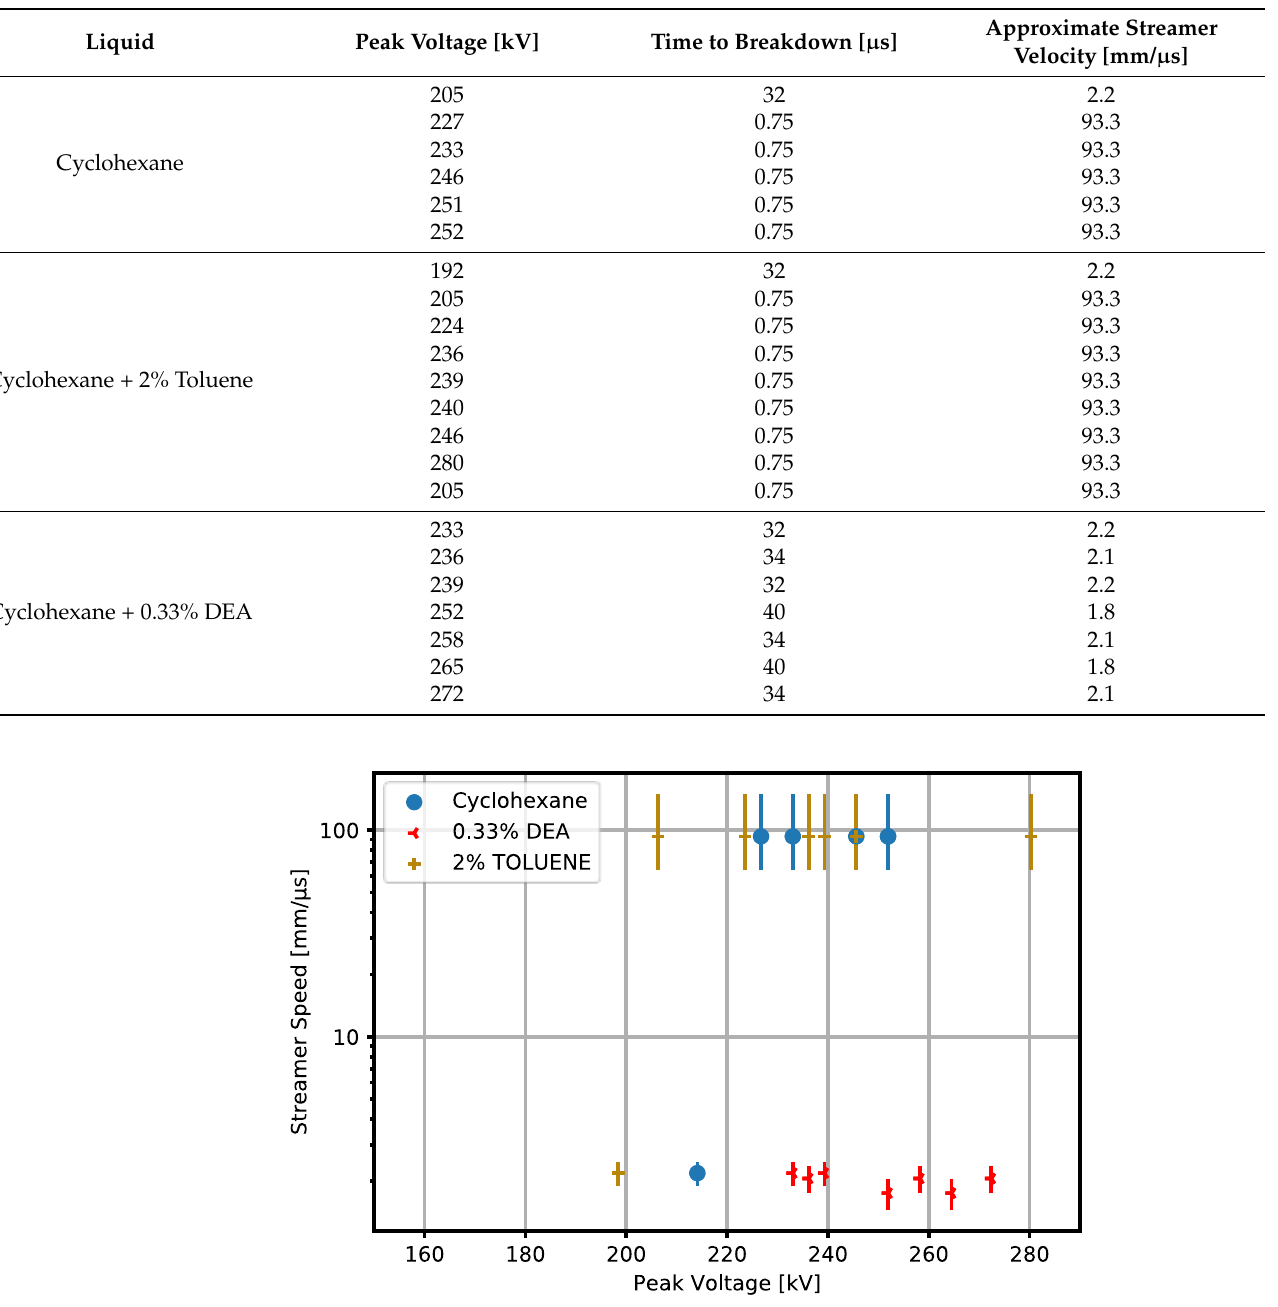
Table A1. The time to breakdown and inferred overall streamer velocity for pure cyclohexane and mixtures of 2% toluene and 0.33% DEA of in cyclohexane. Applied voltage was a positive polarity lightning impulse (1.2/50 µ s) with a 70 mm gap (point-plane arrangement). This data serves as a check of the repeatability of the results presented in Section 3.4, as a new needle and new batches of liquids were used.